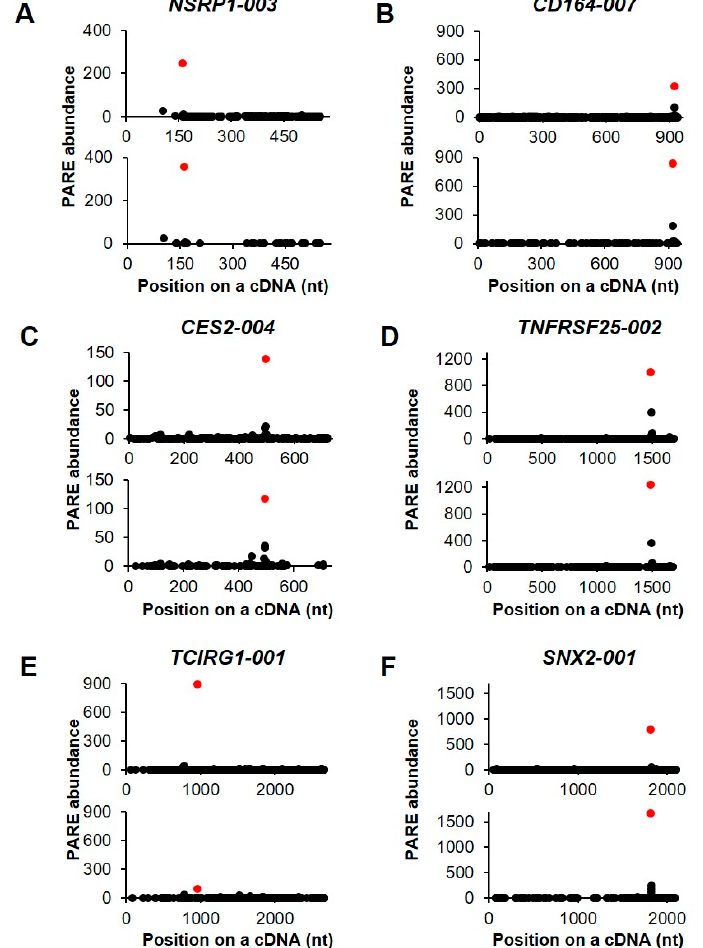
Figure 6. Selected examples of decay plots. ( A – F ). D-plots for six endonucleolytically cleaved transcripts and representative of two biological replicates. The normalized abundance of the PARE sequence is plotted on the cDNA position. Red dots indicate the most abundant PARE sequences.